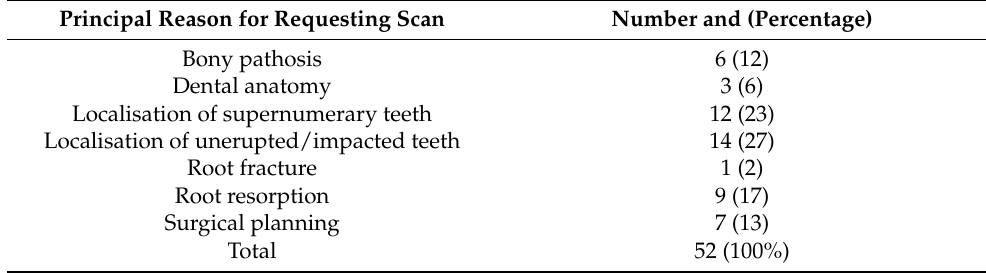
Table 3. Table showing the principal reason for requesting a CBCT in the paediatric patient.